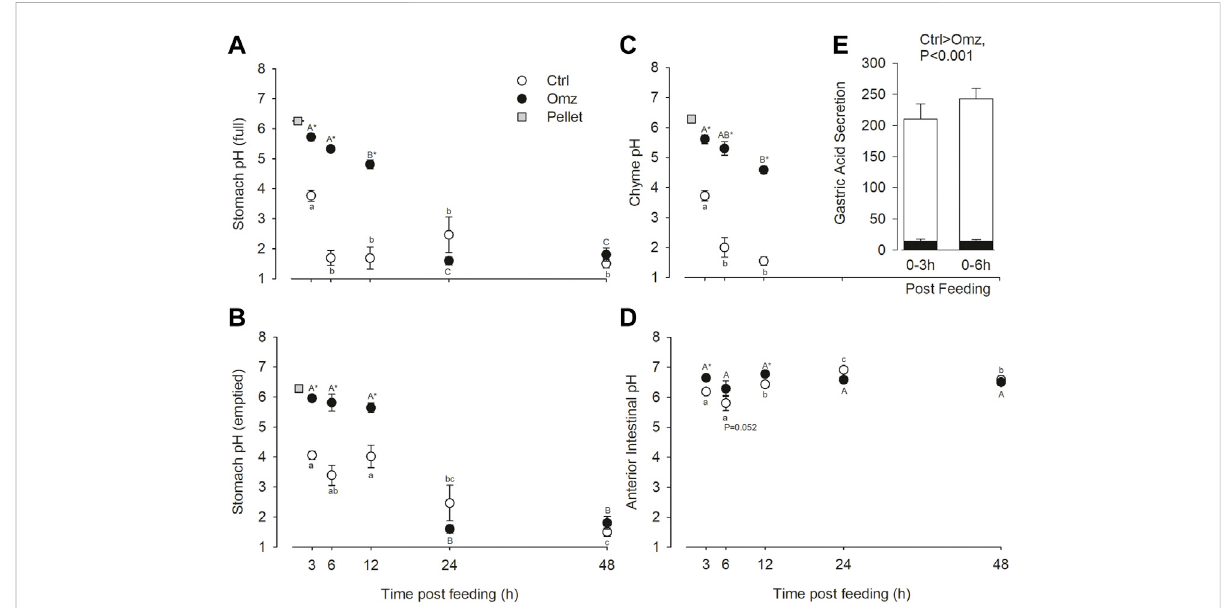
FIGURE 1 Nile tilapia ( Oreochromis niloticus ) gut pH measurements and gastric acid secretion rates. PIT tagged Nile tilapia were fed a 1% BM ration of pelletsthatwereeithershamtreated(Control;white fi ll)ordosedwithomeprazoleat25 mg kg − 1 BM(Omeprazole;black fi ll)for30 days.Tilapiawere sampled at 3-h, 6-h, 12-h, 24-h and 48-h post-feed. The pH of the full stomach (A) , the emptied stomach (mucosa only) (B) , the isolated stomach chyme (C) ,andtheanteriorintestinewithcontents (D) weremeasured.Note,stomachchymewasnotpresentpast12 hpost-feed,sonodatais present at 24 and 48 h (E) Gastric acid secretion rates (µEq H + g − 1 feed h − 1 ) were estimated over the 0 – 3 h and 0 – 6 h post prandial periods from pHchangein (A) andthepellettitrationcurve(SupplementaryFigureS1).Datawereanalyzedbytwo-wayANOVAwithSNKposthoctest;n=6.Time points with unshared letters are signi fi cantly different from each other. Asterisks signify signi fi cant differences between the two treatment